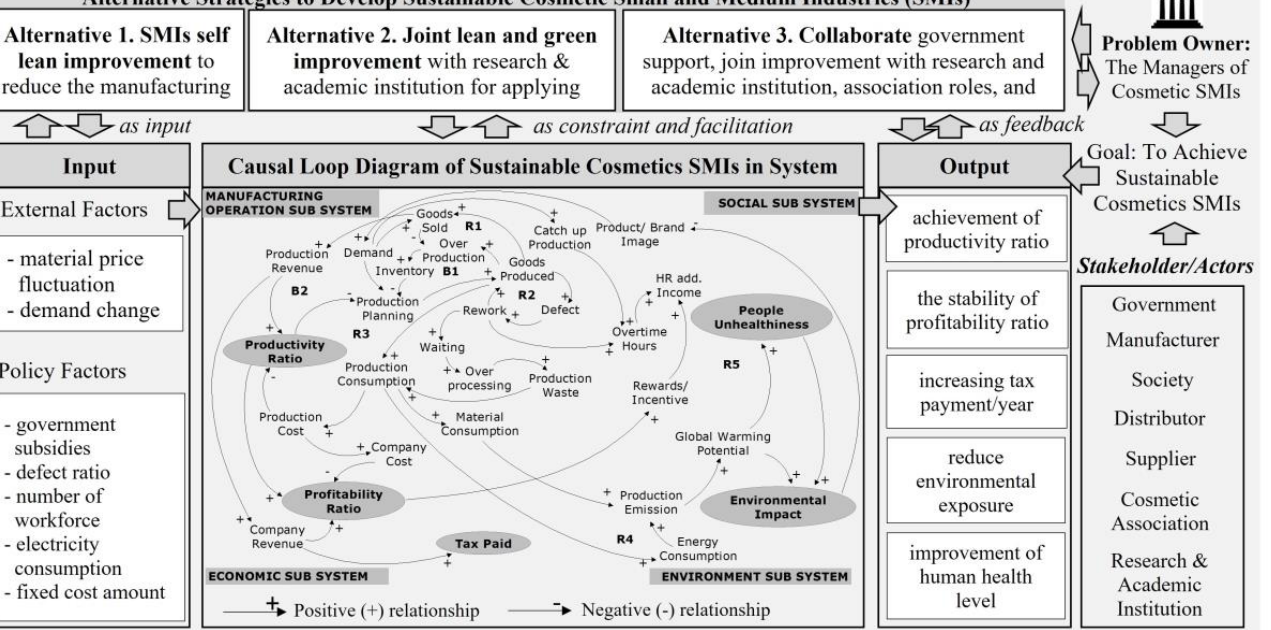
Figure 5. Conceptual model of sustainable cosmetics small and medium industries [26].